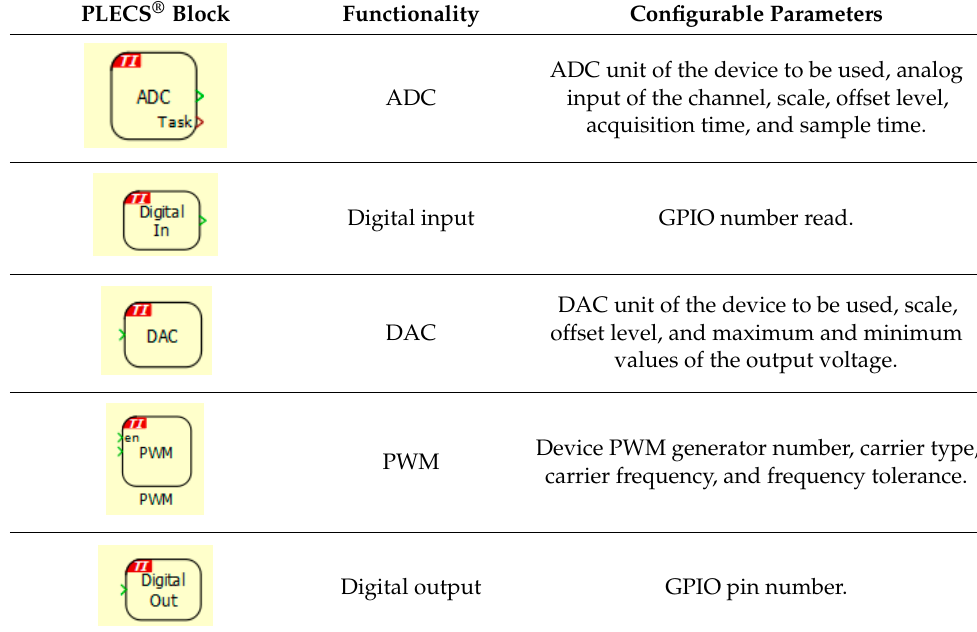
DAC unit of the device to be used, scale, DAC offset level, and maximum and minimum values of the output voltage.